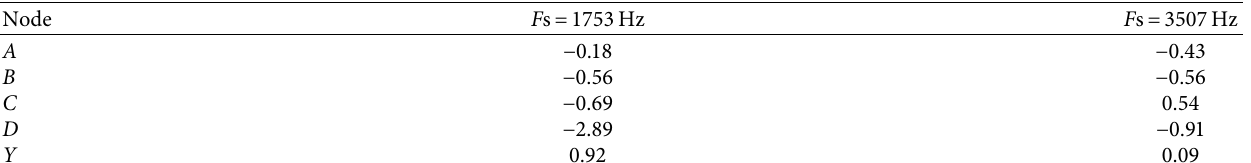
Figure 10: Harmonic power flow representation with 6-pulse and 12-pulse converters (at Node B and Node D respectively) along with one 3rd harmonic source at C . Table 10: Outcomes of two 6-pulse converters connected at node B and node D , respectively.